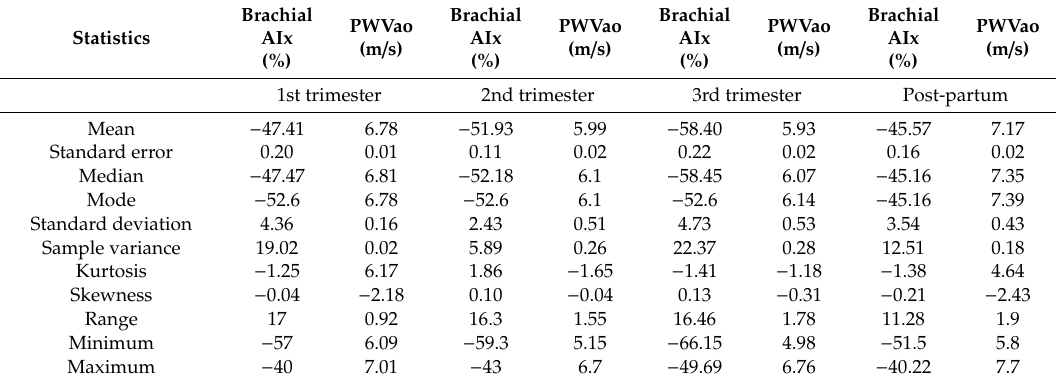
Table 4. The central tendency and dispersion indicators calculated on arterial sti ff ness characteristics for group 1 (healthy pregnant patients, N1 =